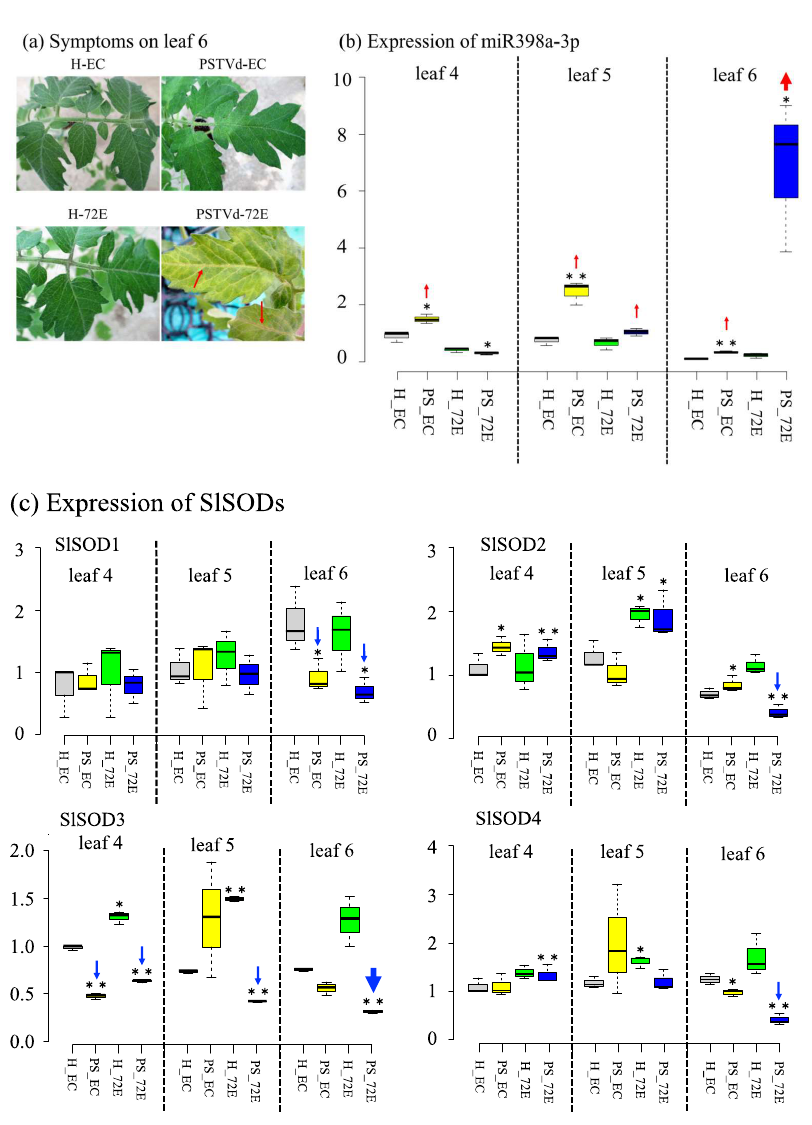
Figure 8. Analysis of miR398a-3p and tomato SODs expression levels in healthy leaves and PSTVd-infected leaves with or without showing necrosis. Panel ( a ): Three plants each of tomato lines 72E and EC were infected with PSTVd. At 4 wpi, only PSTVd-72E (PS_72E) started to show yellowing accompanied with vein necrosis (arrows) on leaves 5 and 6 (numbers from the bottom). Panel ( b ): RT-qPCR analysis of miR398a-3p expression revealed that levels of miR398a-3p were unusually high in leaf 6 of PS_72E, which showed necrosis ( thick red arrow ). Relatively high levels of expression were also found in leaves 4 and 5 in PSTVd-EC (PS_EC) and in leaf 5 in PS_72E ( thin red arrow ), but the levels were approximately four to five times lower than those in leaf 6 of PS_72E. Samples were collected at 4 wpi. The assay was repeated twice, and each analysis consisted of three biological replicates collected from three plants per treatment. Panel ( c ): RT-qPCR analysis of the expression of four tomatoes Cu / Zn-SODs (i.e., SlSOD1 , SlSOD2 , SlSOD3 , and SlSOD4 ) in the same samples revealed that, in response to the highest level of miR398a-3p, SlSOD3 expression decreased most significantly in leaf 6 of PS_72E ( thick blue arrow ) compared with the healthy line EC (H_EC). SlSOD3 expression levels were also significantly decreased in leaves 4 and 5 of PS_72E, and in leaf 4 of PS_EC. In addition, SlSOD1 , SlSOD2 , and SlSOD4 expression levels were significantly lower in leaf 6 of PS_72E ( thin blue arrow ), which showed necrosis. SlSOD3 expression was somewhat higher in leaves 5 and 6 in H_72E. The values with the double asterisk (**; p < 0.01) and single asterisk (*; p < 0.05) were statistically significant at 1% and 5% levels compared to